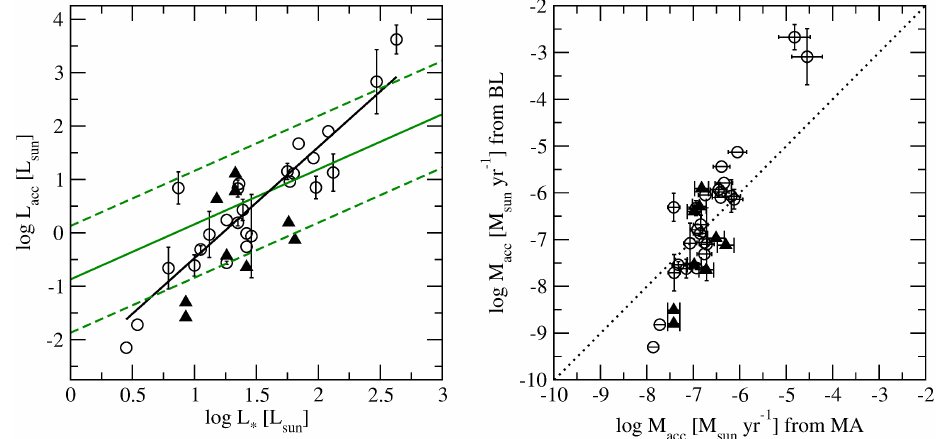
Figure 3. ( Left panel ) Accretion luminosity versus stellar luminosity as derived in Blondel & Tjin A Djie (2006) [48] from BL for a sample of HAe stars. The best fit is indicated with the black line (slope ∼ 2). The trend ( ± 1 dex) that HAes (and TTs) follow when accretion luminosities are estimated from MA is indicated with the green lines (slope ∼ 1). ( Right panel ) Comparison between mass accretion rates as inferred from BL and MA for the same sample. Equal values are indicated with the dotted line. ( Both panels ) The black triangles represent lower limits for the accretion estimates from